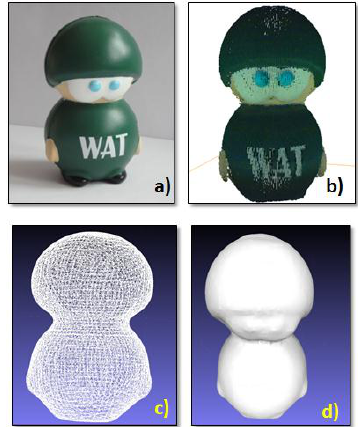
Figure 6. Spongiform mascot of WAT university: a) photo of the real object; b) scanned cloud of points; c) processed data in form of TIN surface d) 3D model The next subject of the analysis was glass bottle of perfumes with a different type of glass. During the scanning, it was observed that the glass objects are hard to scan correctly because the glass reflects the light. Figure 7 shows an unsuccessful attempt of scanning the flacon and its smooth glass surface.